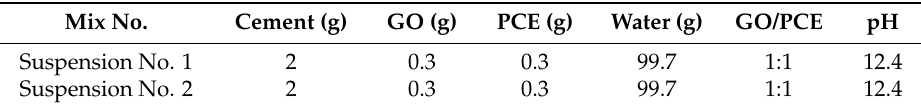
Table 3. Mix proportions of C-GO-PCE suspensions.